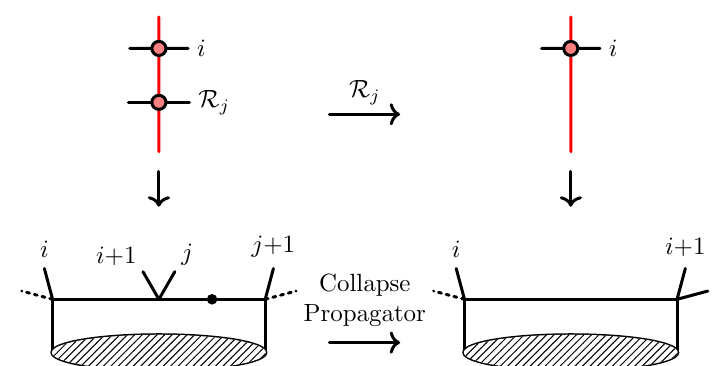
Figure 4. The graph operation R j relaxes L by removing the condition that L must pass through the line ( j j +1); this is equivalent to removing the on-shell condition hL j j +1 i = 0. On Landau diagrams, this corresponds to collapsing the propagator indicated by the (cid:12)lled dot in the bottom (cid:12)gure on the left. The shaded region in the (cid:12)gures represents an arbitrary planar sub-graph. A dashed external line on a Landau diagram may be either one massless external leg so the whole corner is massive, or completely removed so the whole corner is massless. It is to be understood that the graphical notation implies that j 6 = i + 2 and i 6 = j + 2; otherwise, the two empty nodes in the top left diagram would be represented by a single (cid:12)lled node on which the action of R is unde(cid:12)ned; the appropriate graph operation in this case would instead be U . The last operation, U , corresponds to \un-pinning" a (cid:12)lled node (hence \ U "). Un- pinning means removing one constraint from a pair hL i (cid:0) 1 i i = hL i i +1 i = 0. The line L , which was pinned to the point i , is then free to slide along the line segment ( i (cid:0) 1 i ) or the (cid:12)lled node at the point i with a single empty node along the line segment ( i i (cid:6)